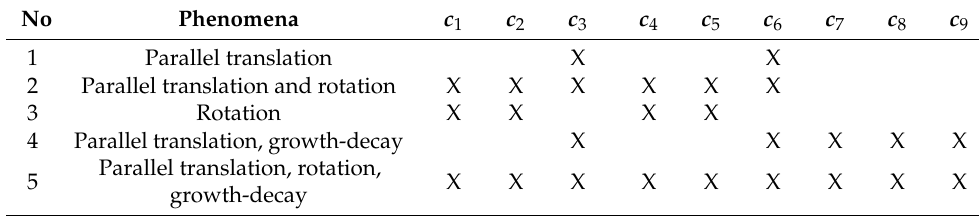
Table 2. Combinations of advection vectors parameter, adopted from different rainfall phenomena [15]. No